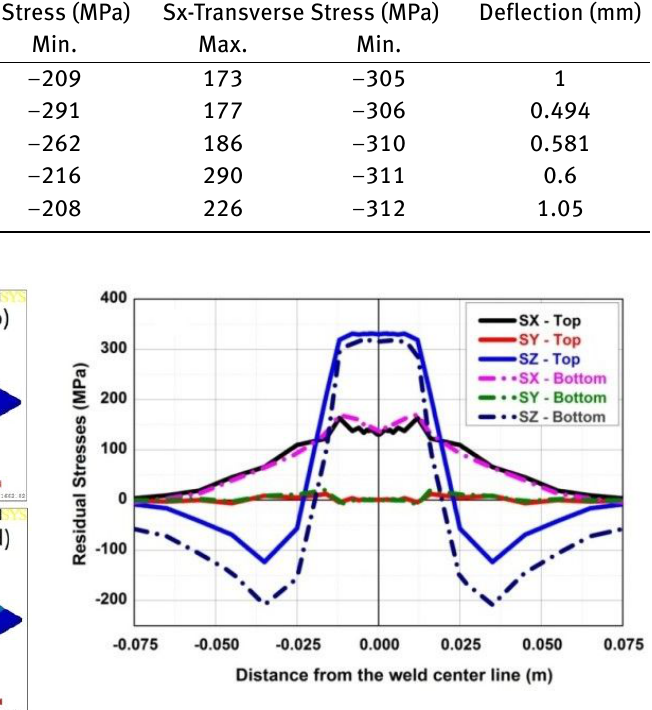
Figure 7: Simulated Welding residual stresses at mid span of weld centre line– No constraint (Case A)